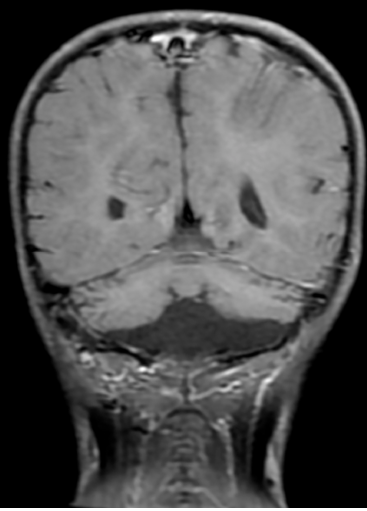
Figure 2. Brain magnetic resonance imaging of the patient in December 2014 showing characteristic cerebellar hypoplasia.